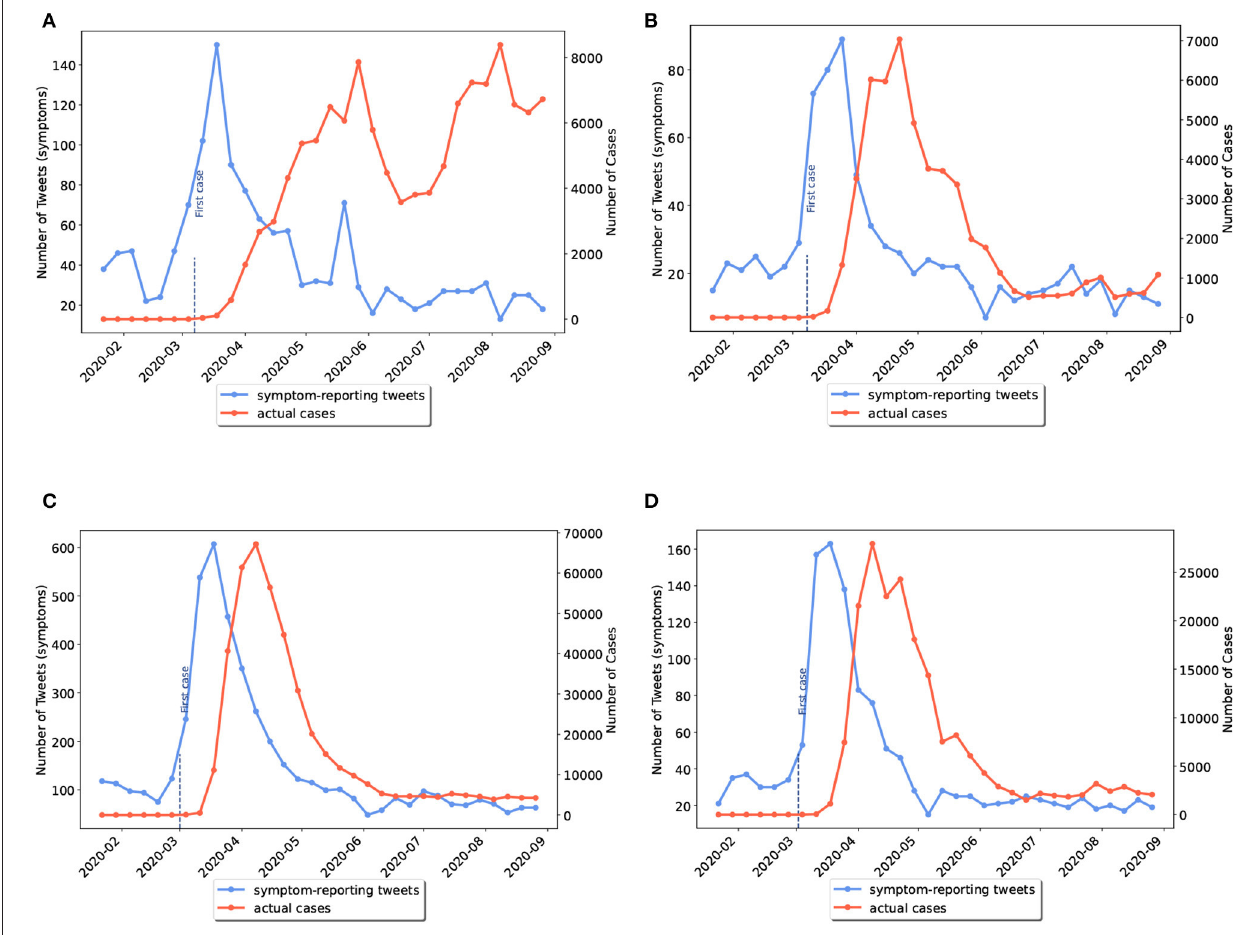
FIGURE 3 | Weekly comparison of symptom-related tweets and the actual number of cases in provinces with first wave of disease (category I). (A) Virginia, (B) Connecticut, (C) New York, (D) New